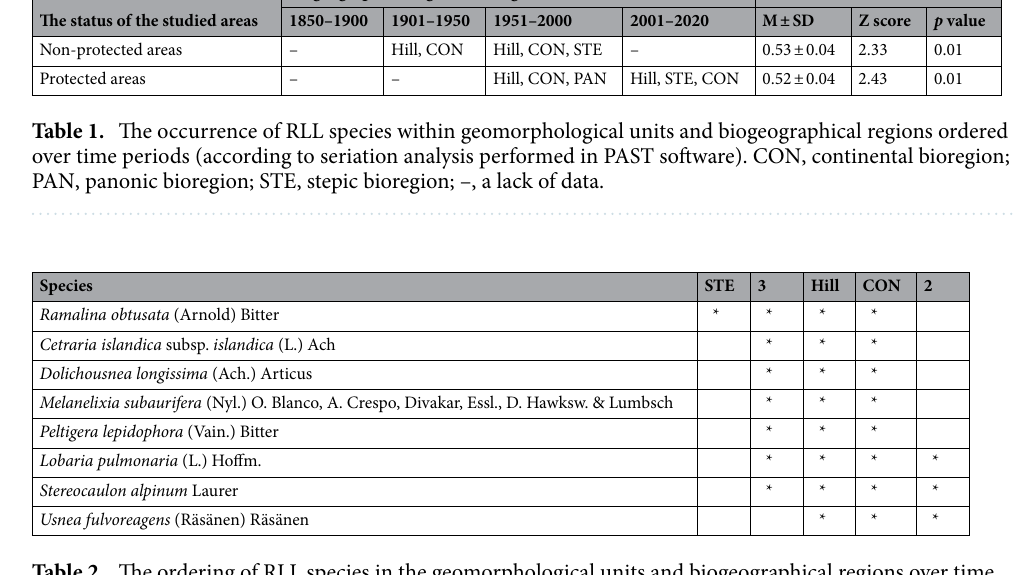
Table 2. The ordering of RLL species in the geomorphological units and biogeographical regions over time within NPAs (according to the seriation analysis performed in PAST, based on the unconstrained algorithm). 2–1901–1950; 3–1951–2000; asterisks indicate the occurrence of RLL species in the geomorphological units and biogeographical regions over time; empty cells indicate no available data.